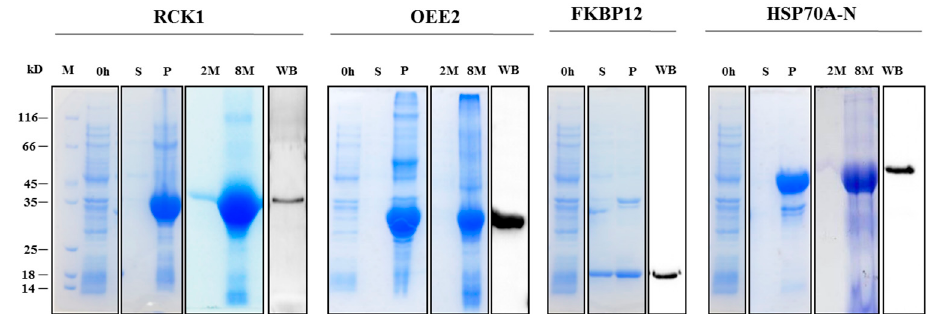
Figure 3. Recombinant protein expression and antibody verification. Candidate genes ( RCK1 , OEE2 , FKBP12 , and HSP70A -N terminal sequence) were cloned into expression vector pET30a and transformed into Escherichia coli . Expression of recombinant proteins was induced by adding isopropyl β - D -1-thiogalactopyranoside (IPTG) to lysogeny broth (LB) medium. E. coli cells were collected by centrifugation and total proteins were extracted after sonication. Supernatant and pellet samples were separated by centrifugation. Recombinant proteins in pellet form were washed in 2 M urea and then dissolved in 8 M urea. SDS-PAGE-separated proteins were visualized by Coomassie Blue staining. Dissolved recombinant protein was used to generate polyclonal antibodies. To verify the specificity of antibodies, Western blotting analysis was carried out against dissolved proteins.